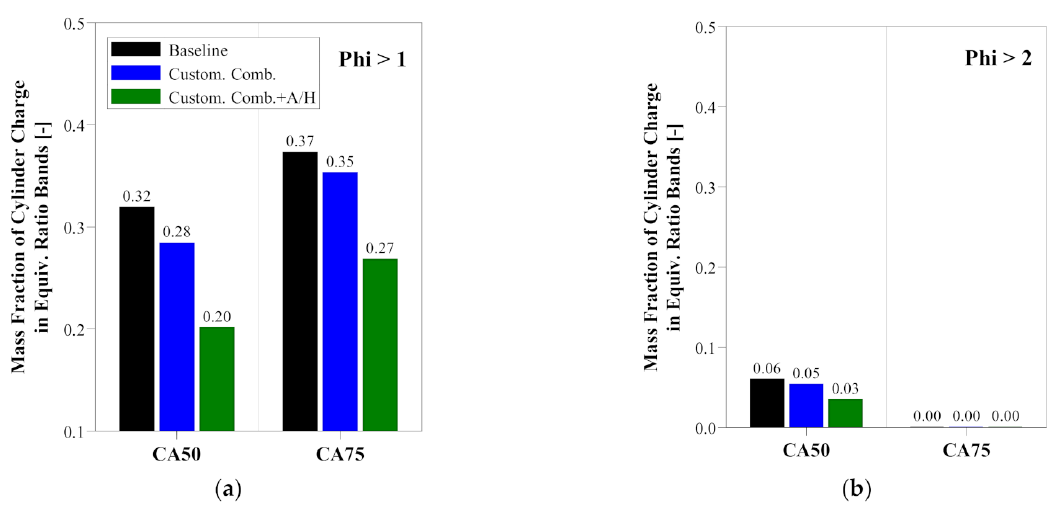
Figure 12. Comparison of in-cylinder air utilization characteristics for GCI at CA50 and CA75: ( a ) Phi > 1; ( b ) Phi >